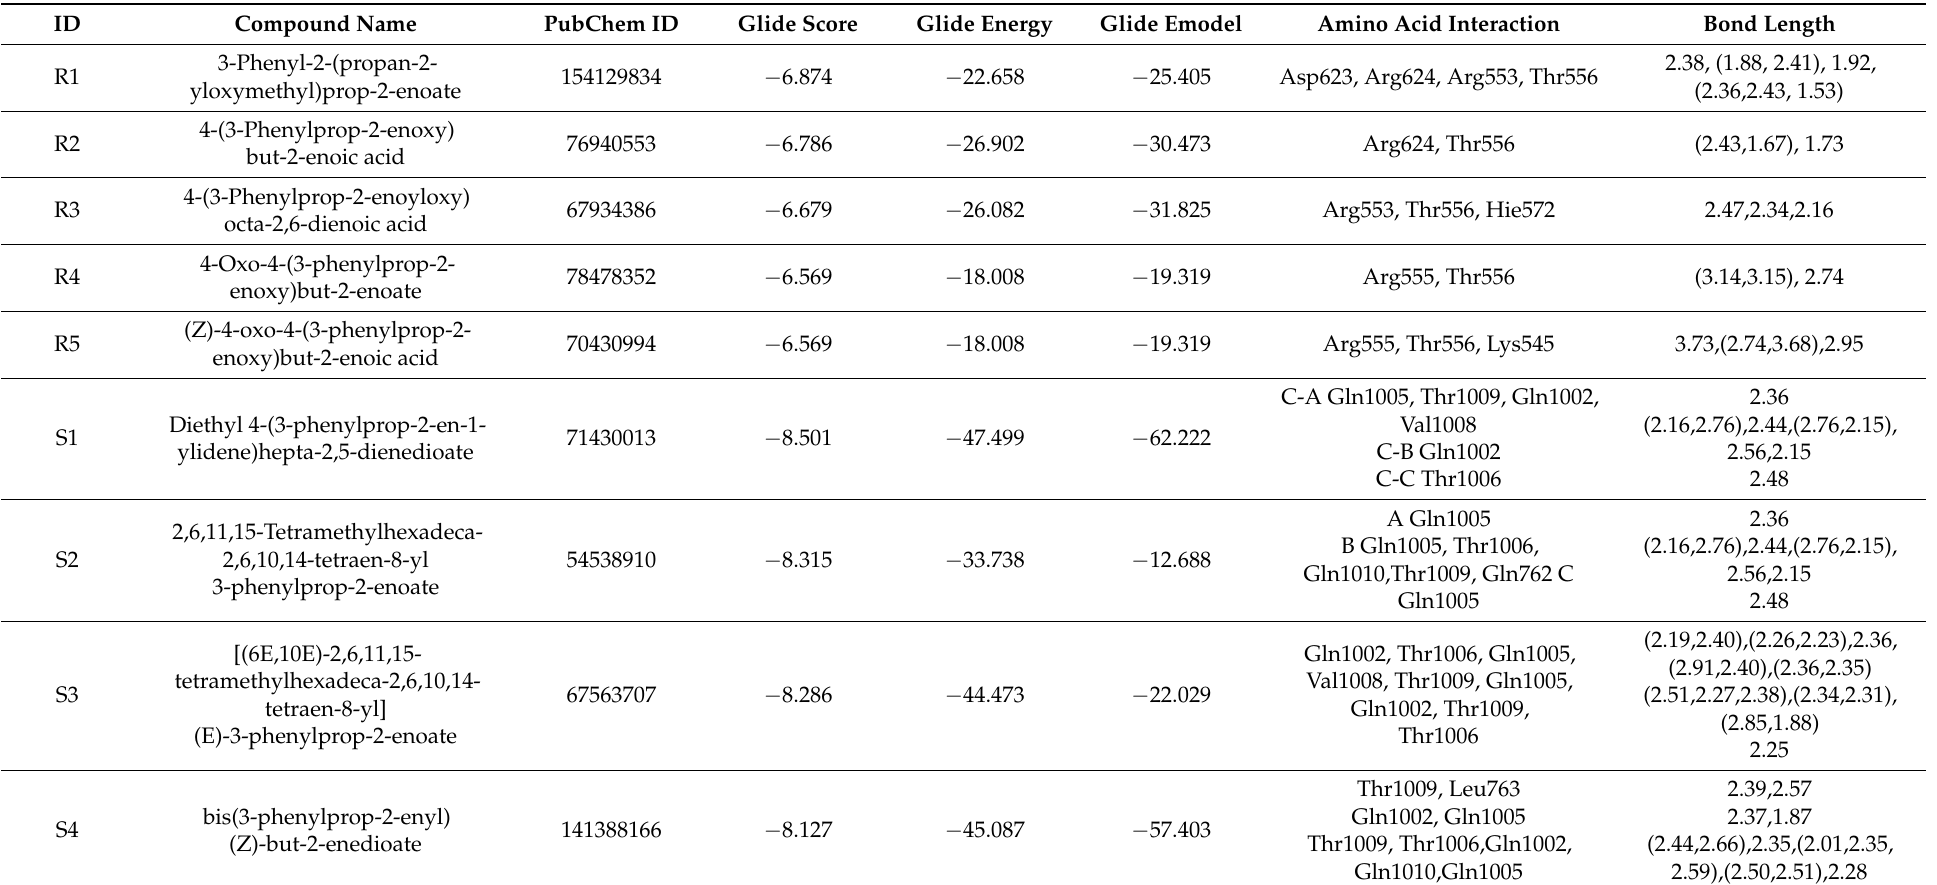
Table 2. Molecular docking of (S)-Goniothalamin analogues, with multiple target proteins of RDRP (R), spike glycoprotein (S), and main protease (M) interaction, docking score, and their bond length are